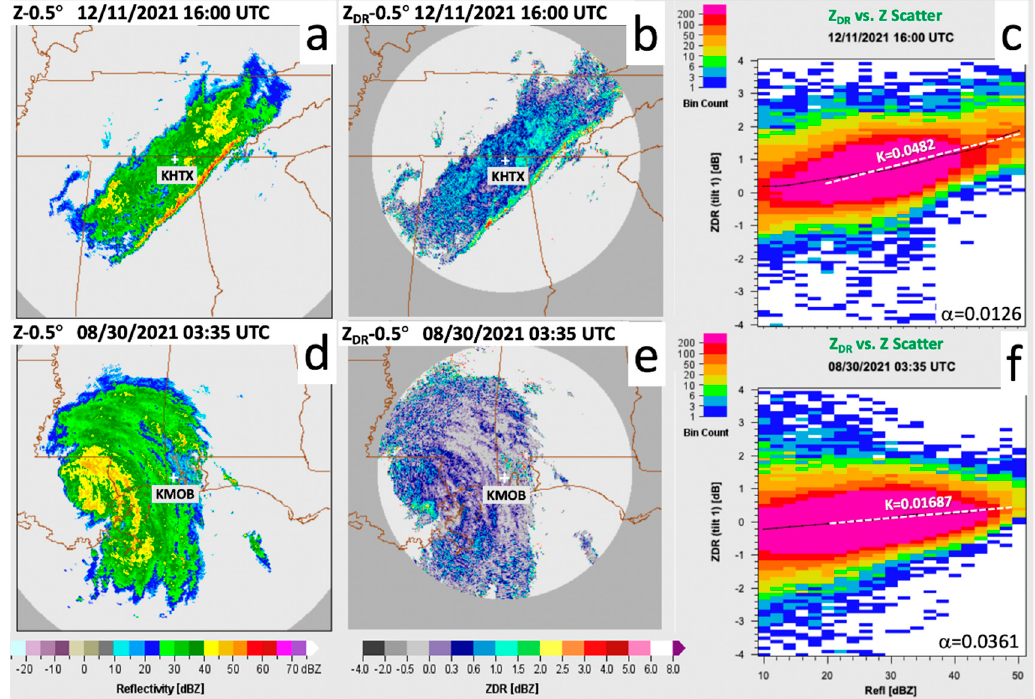
Figure 20. Reflectivity Z ( a , d ), differential reflectivity Z DR ( b , e ) and Z – Z DR scatter plot ( c , f ) from KHTX ( a – c ) at 1600 UTC 11 Dec. 2021 and KMOB ( d – f ) at 0335 UTC 30 Aug. 2021. The black dots in ( c , f ) indicate median Z DR values, and the white dashed lines represent the linear fit to the median Z DR vs. Z .